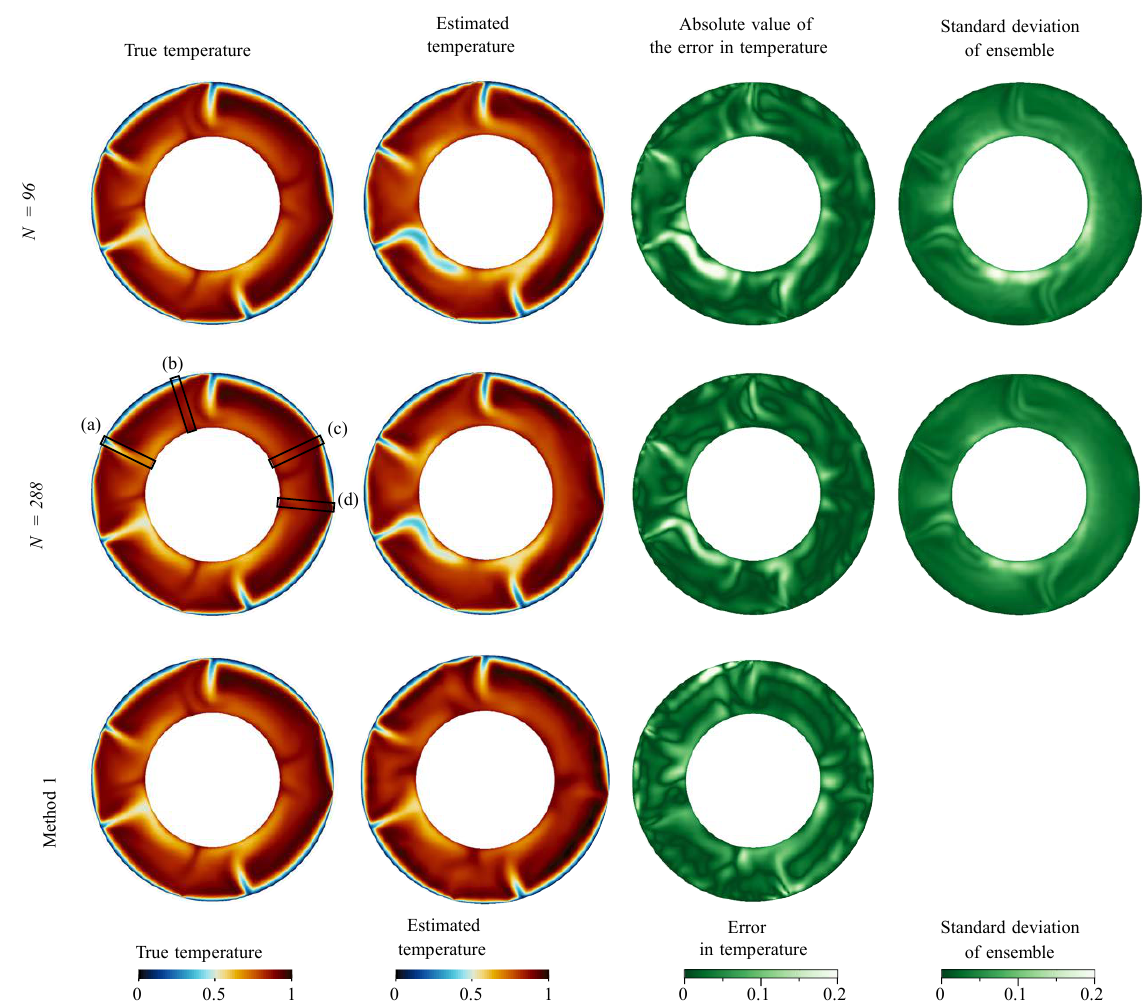
Figure 10. Comparison of estimated states after 150Myr for evolution A of Fig. 3. First row: ensemble Kalman filter (EnKF) with N = 96, (cid:96) v = 0 . 5 and (cid:96) h = π/ 6; second row: N = 288, (cid:96) v = 0 . 7 and (cid:96) h = π/ 10 (these localization length correspond to the optimal parameters determined previously.); third row for method 1 (third row). The first column represents the true temperature field at 150Myr, the second column is the analyzed temperature field, the third column is the absolute error in temperature value and the fourth column is the estimated error in the analyzed field (spread of the ensemble). In the true temperature field of EnKF288, we framed the location of the subduction (a) , plume (b) , ridge initiation (c) and stable ridge (d) studied in Fig.